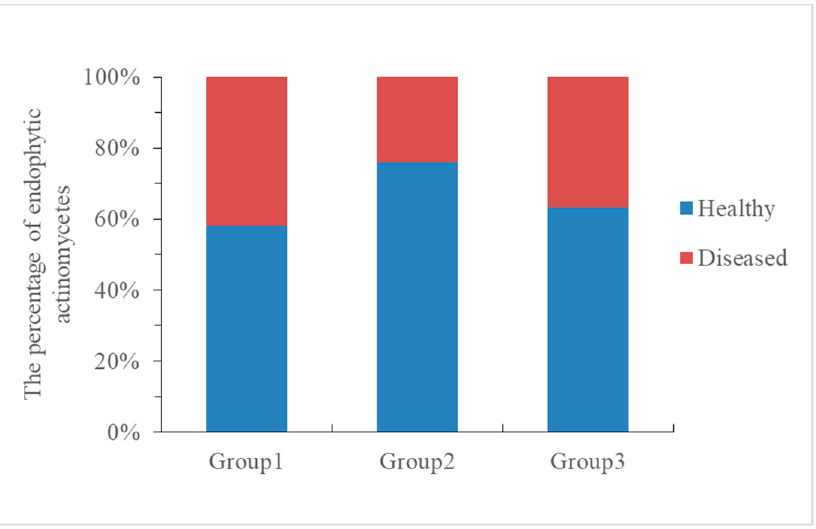
Figure 4. The percentage of endophytic actinomycetes in Group1 (H1-D1), Group2 (H2-D2), and Group3 (H3-D3).